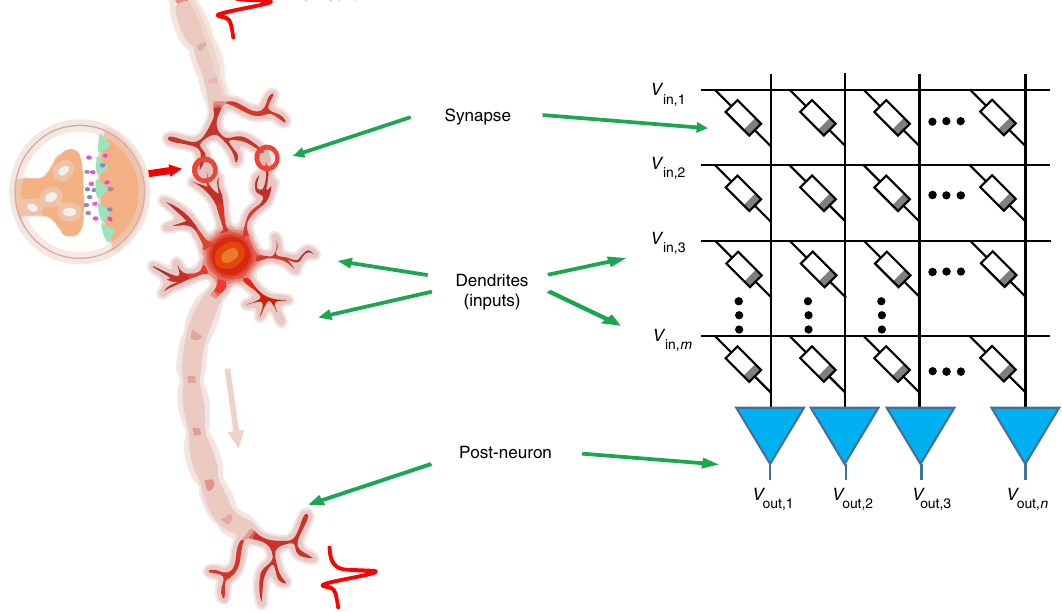
Fig. 1 Comparison of biological and arti fi cial neurons. Schematic of biological neurons and synapses (left) compared with an arti fi cial neural network